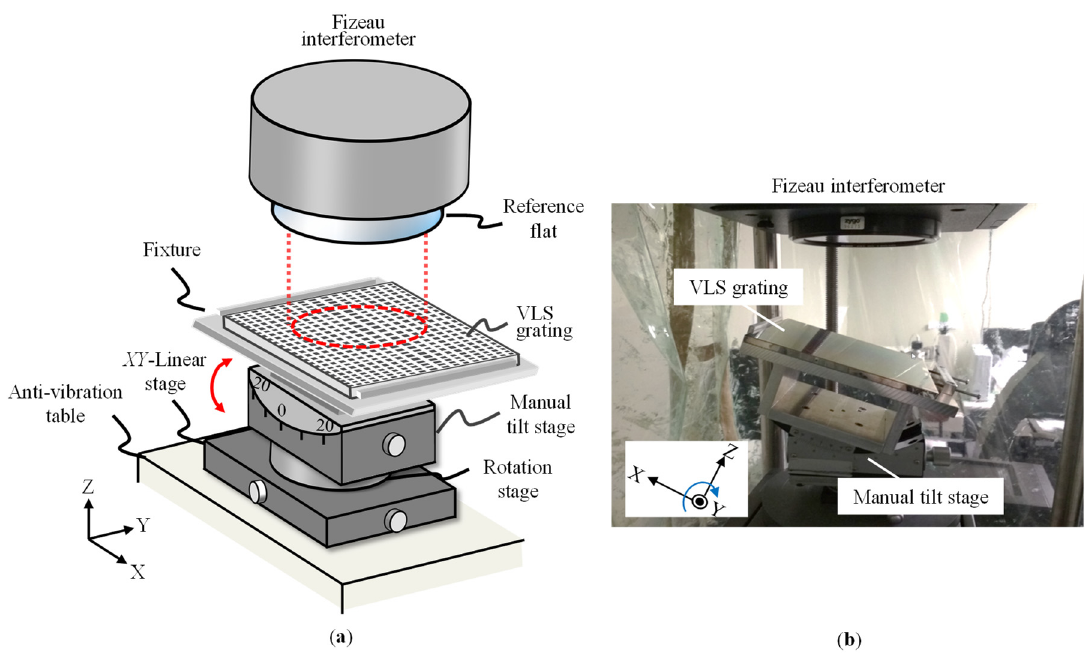
Figure 10. Experiment setup: ( a ) Schematic of the experimental setup with a commercial Fizeau in- terferometer; ( b ) Photograph of the experiment setup.